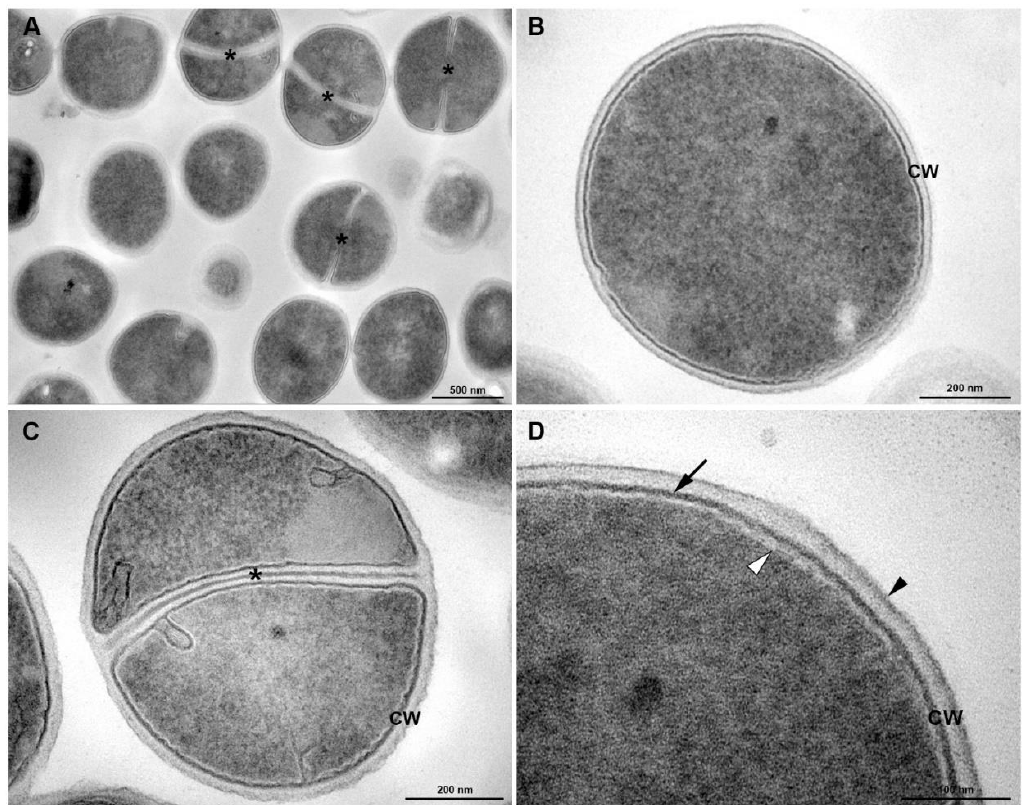
Figure 6. Transmission electron microscopy of S. aureus treated with antibiotics (Norfloxacin MIC/4): ( A ) General view: the cells are round and intact, with a well-defined cell wall. Division septa (*) are seen in some cells. ( B , C ) Detailed view of dividing ( B ) and non-dividing ( C ) bacteria showing the tripartite cell wall (CW). Asterisks indicate cell wall septa. ( D ) Inset of the cell wall. Black arrowhead, outer highly stained fibrous surface and intermediate translucent region; Arrow, heavily stained inner thin zone; white arrowhead, plasma membrane. Bars: A: 500 nm; B,C: 200 nm; D: 100 nm.